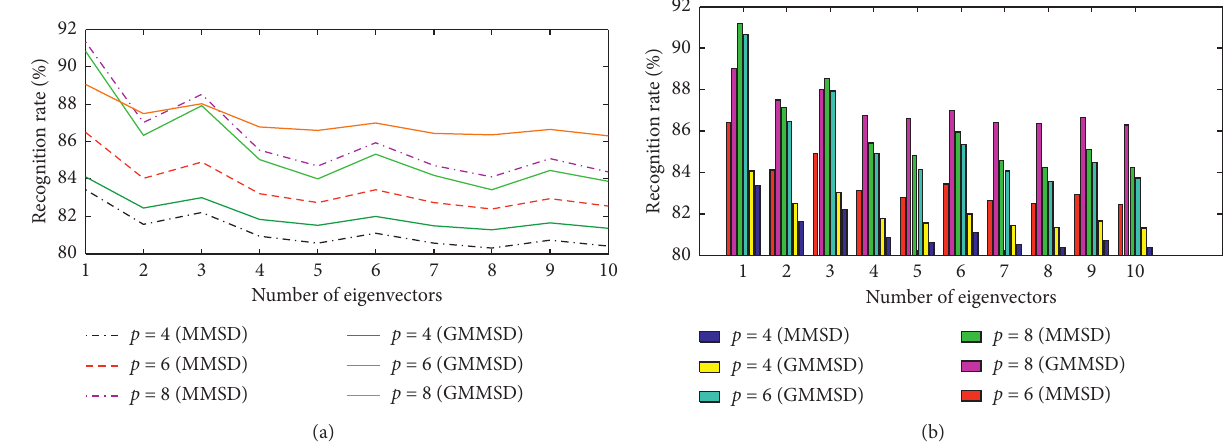
Figure 5: GMMSD versus MMSD recognition rate. (a) RML face library. (b) FERET face